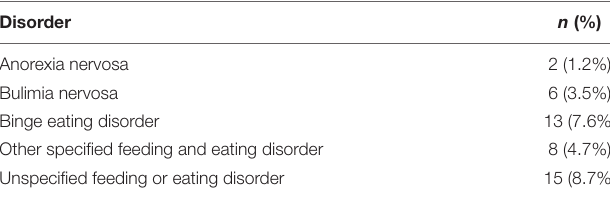
TABLE 5 | Correlation between DEPS-R score and age, duration of diabetes, HbA 1 C, and